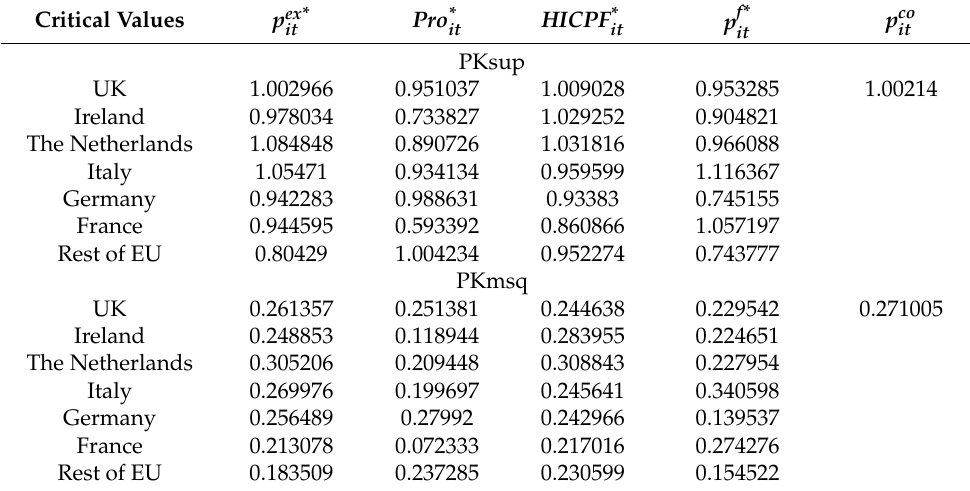
Table A4. Structural stability tests for extra-EU GVECM: Critical values.